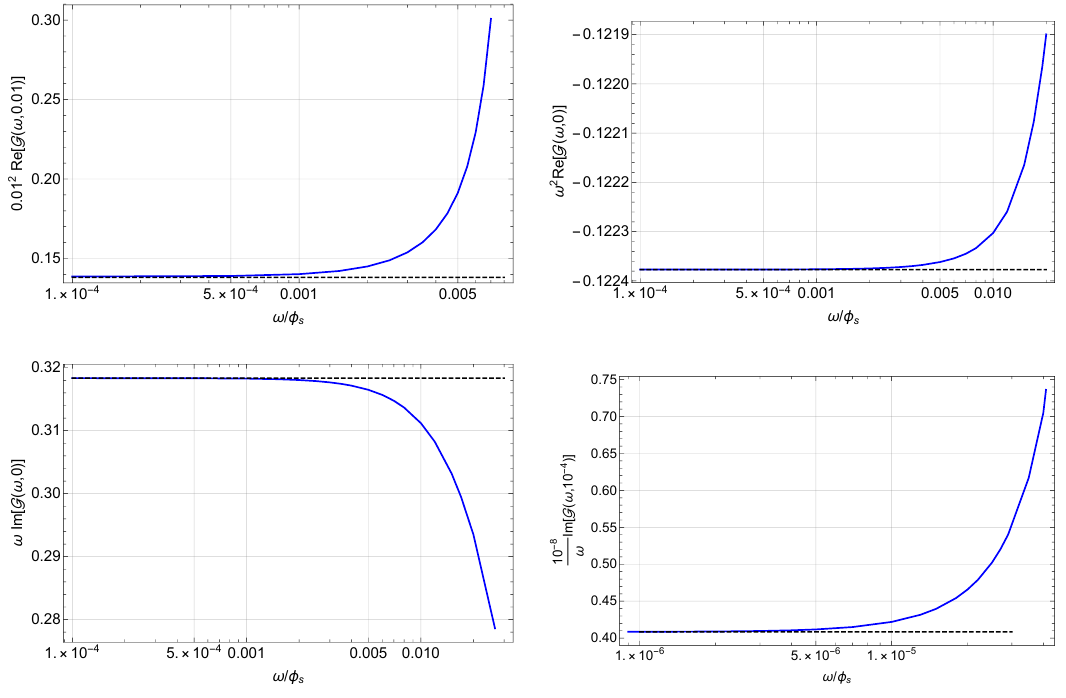
Figure 3 . Plots of ω 2 Re [ G ] lation. The dashed black line corresponds to the analytic prediction. Here { T, c, λ, φ { 0 . 015 , 1 , − 3 / 2 , 1 } .